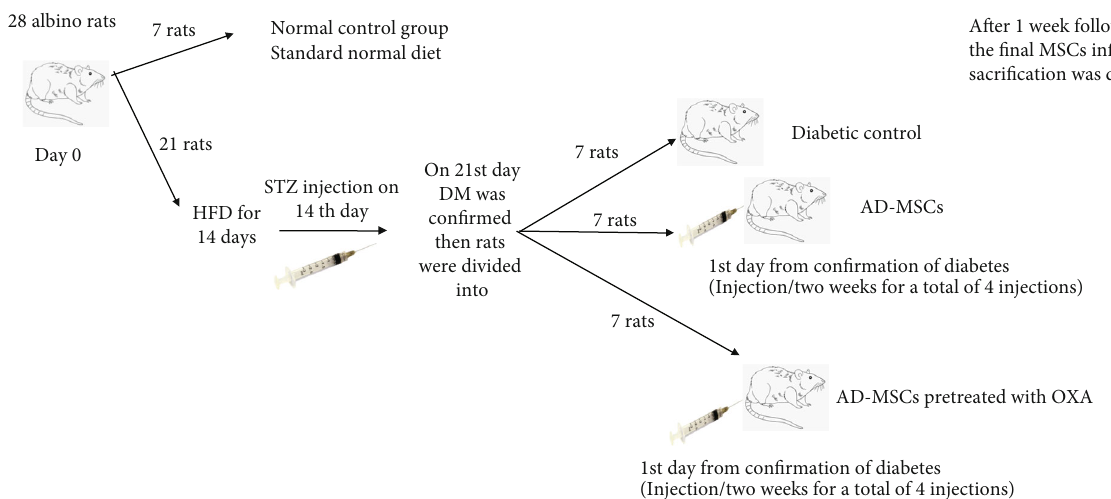
Figure 1: Schematic fi gure illustrating the timeline of the experimental